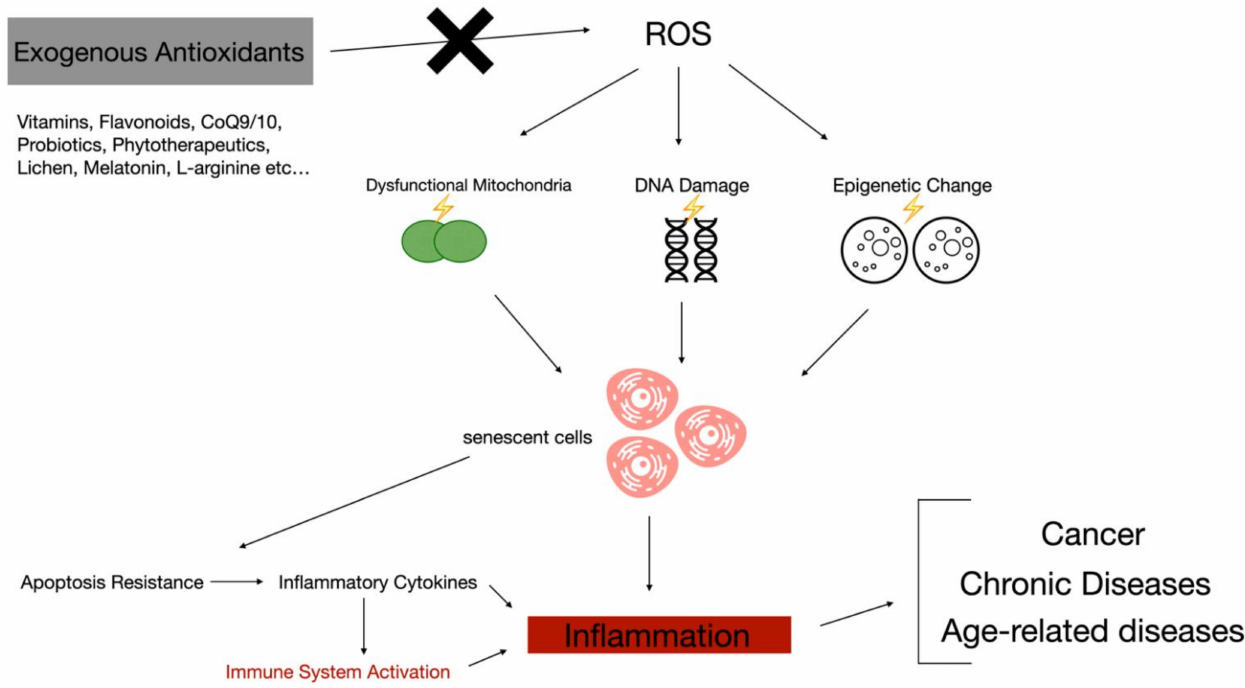
Figure 1. Some of the most studied exogenous antioxidants blocking reactive oxygen species (ROS) cascade in triggering and sustaining chronic inflammation and immune-related